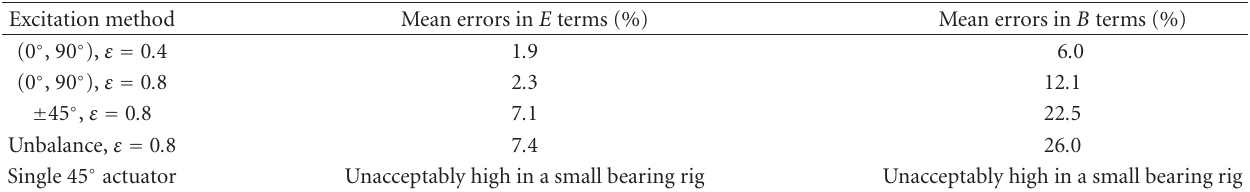
Table 2: Results of error analysis. ω/ Ω = 0 . 3 (dynamic excitation at 15 Hz (single actuator 10/20 Hz) for a bearing running at 3000 rpm). Individual “measurement” errors are 1%/0 . 57 ◦ .